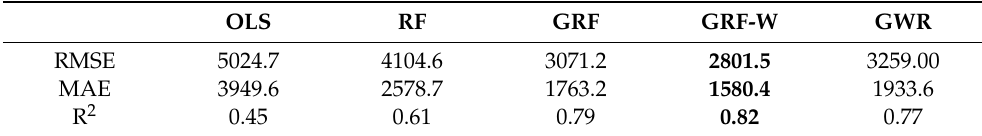
Table 1. Predictive performance of the models on validation data.